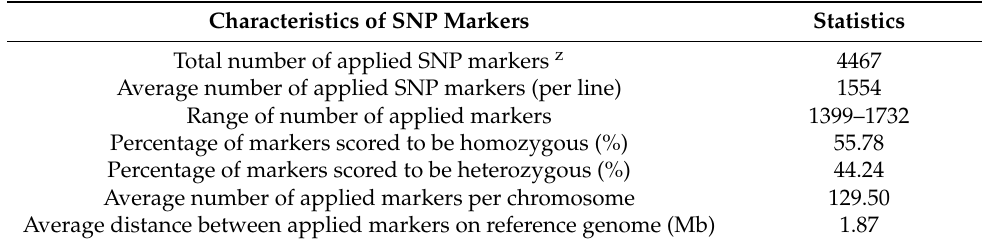
Table 2. Characteristics of single nucleotide polymorphism (SNP) markers used for the estimation of recombination frequencies.